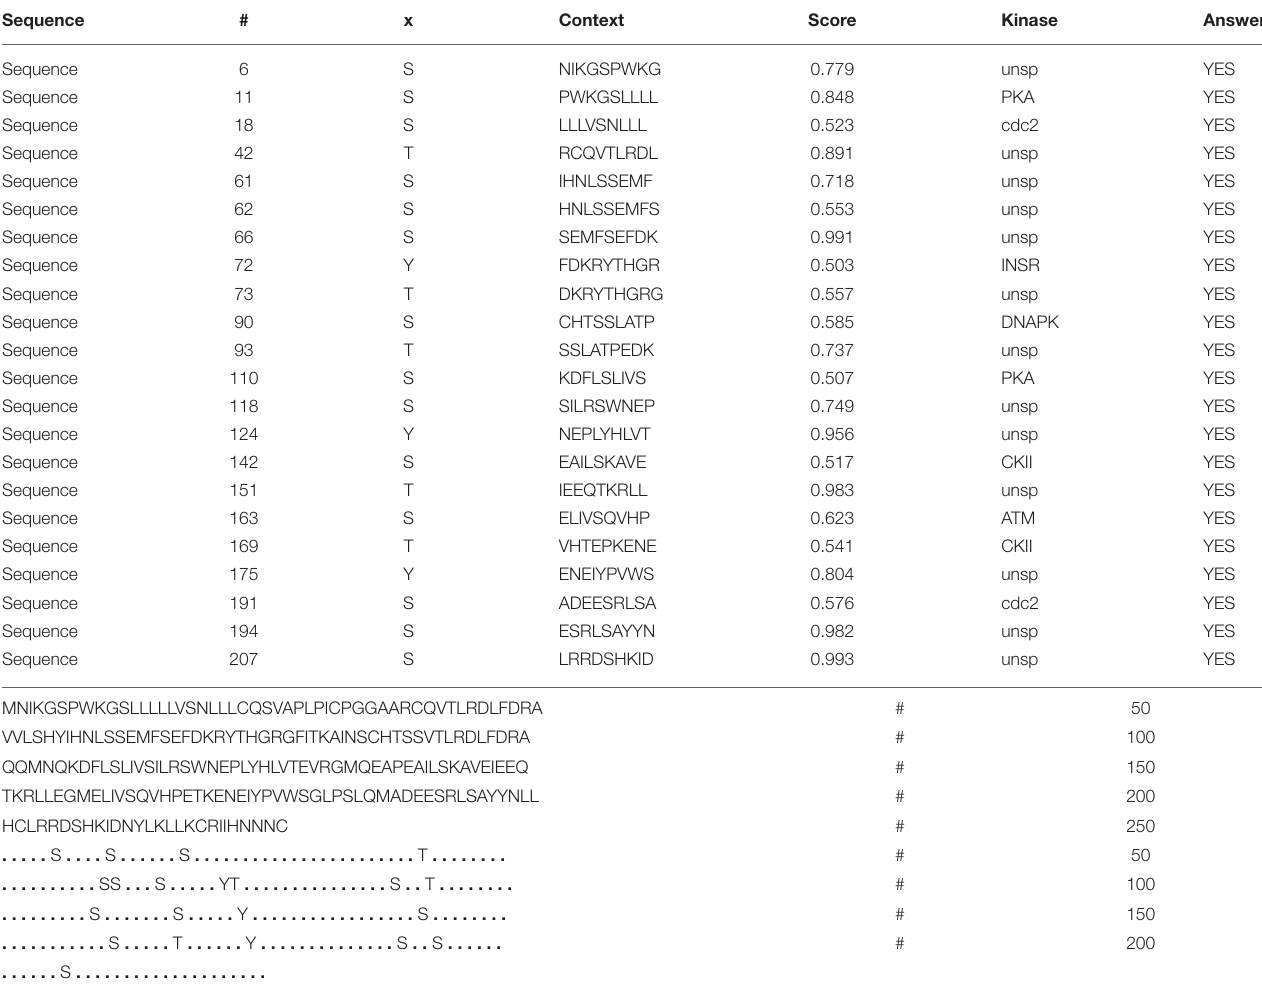
TABLE 6 | Prediction of phosphorylation sites in hPRL (position 1–227) with NetPhos 3.1 Server with a score more than 0.5. Sequence # x Context Score Kinase Answer